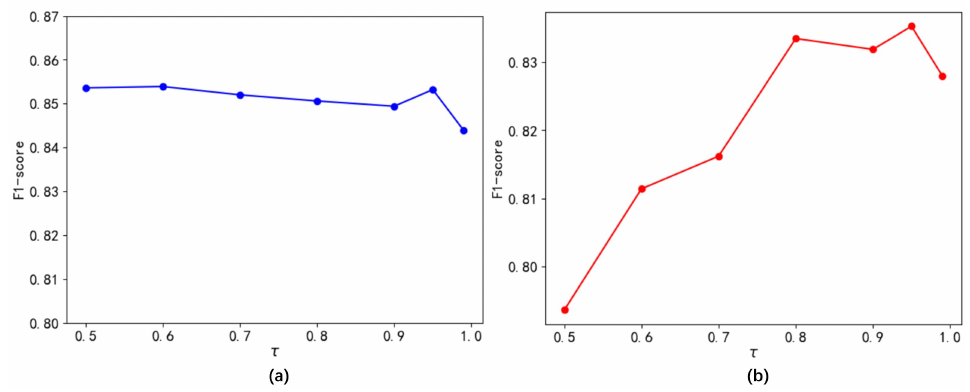
Figure 11. Effects of confidence threshold τ . ( a ) LEVIR2000 dataset. ( b ) WHU